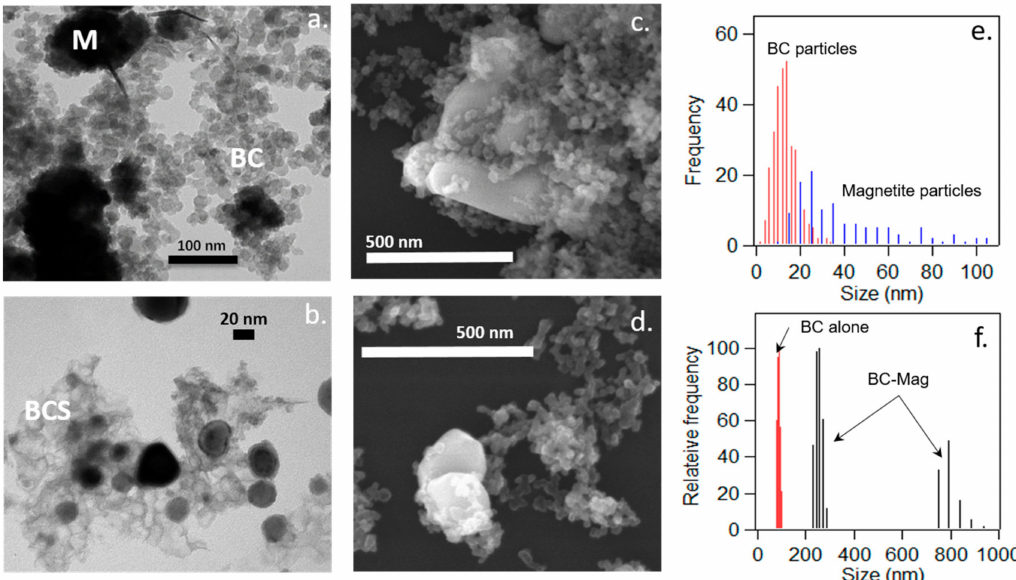
Figure 1. Transmission electron microscopy (TEM) images ( a , b ), scanning electron microscopy (SEM) images ( c , d ), individual component size distributions ( e ), and dynamic light scattering (DLS) whole particle size distributions ( f ) of black carbon-magnetite composite (BC-Mag) particles synthesized at 1000 ◦ C. In the TEM images, electron-dense regions are the iron minerals (M), lighter spherical particles are black carbon (BC), and lighter sheet-like structures are transformed black carbon (BCS). In the SEM images, the magnetite appears as the larger, brighter phases.